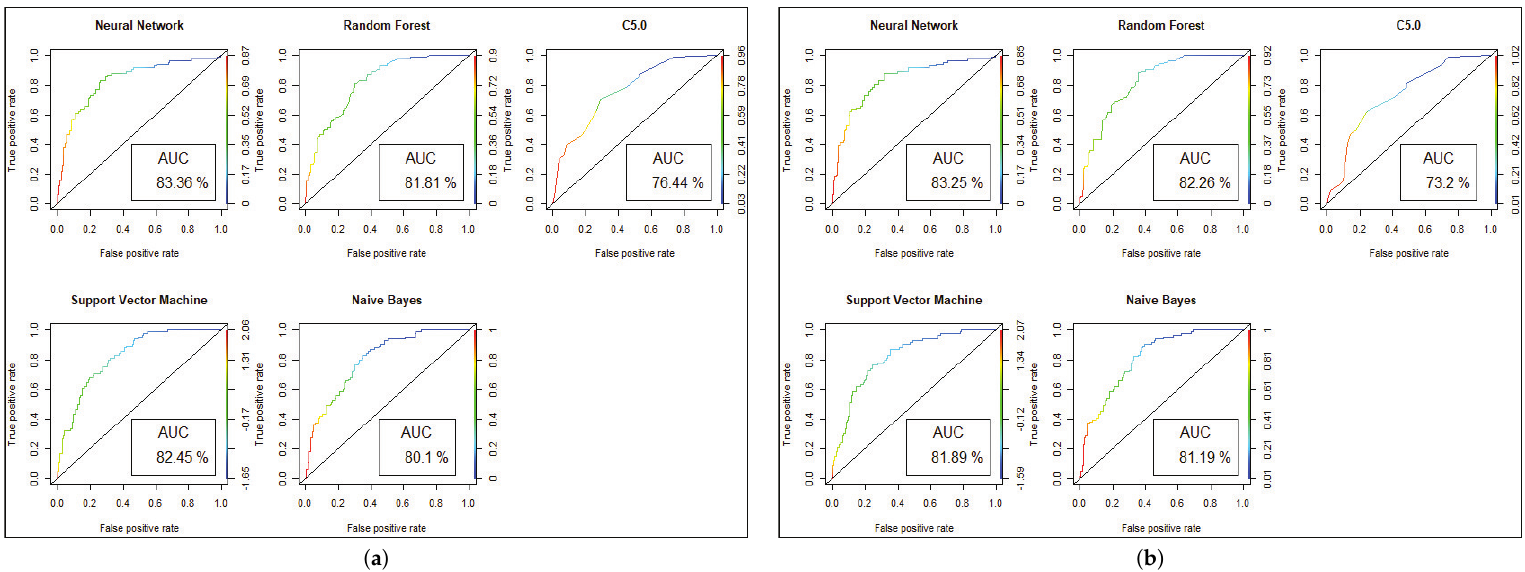
Figure 5. Model performance with ROC curve for Diabetes prediction. ( a ) ROC and AUC before Genetic Algorithm. ( b ) ROC and AUC after Genetic